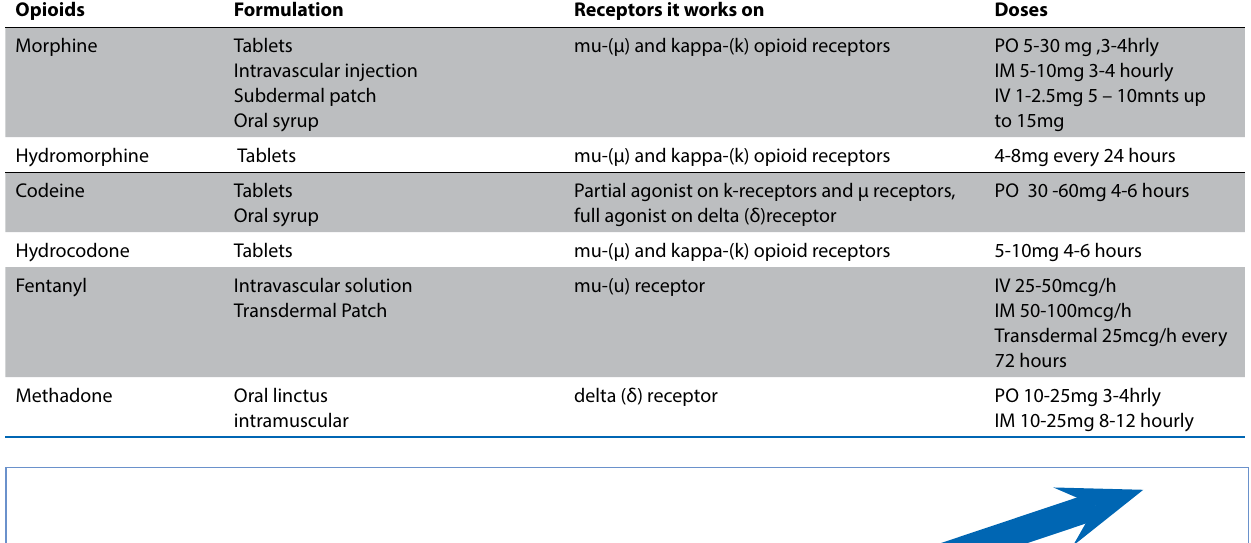
Table 2 : F ormulations, receptors and doses of opioids Opioids